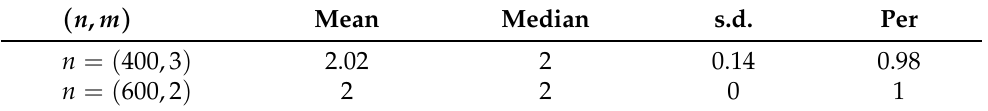
Table 3. The sample mean, median, and standard error (s.d.) of ˆ M and the empirical percentage (per) of ˆ M equal to the true number of subgroups based on 100 replications in Example 2.